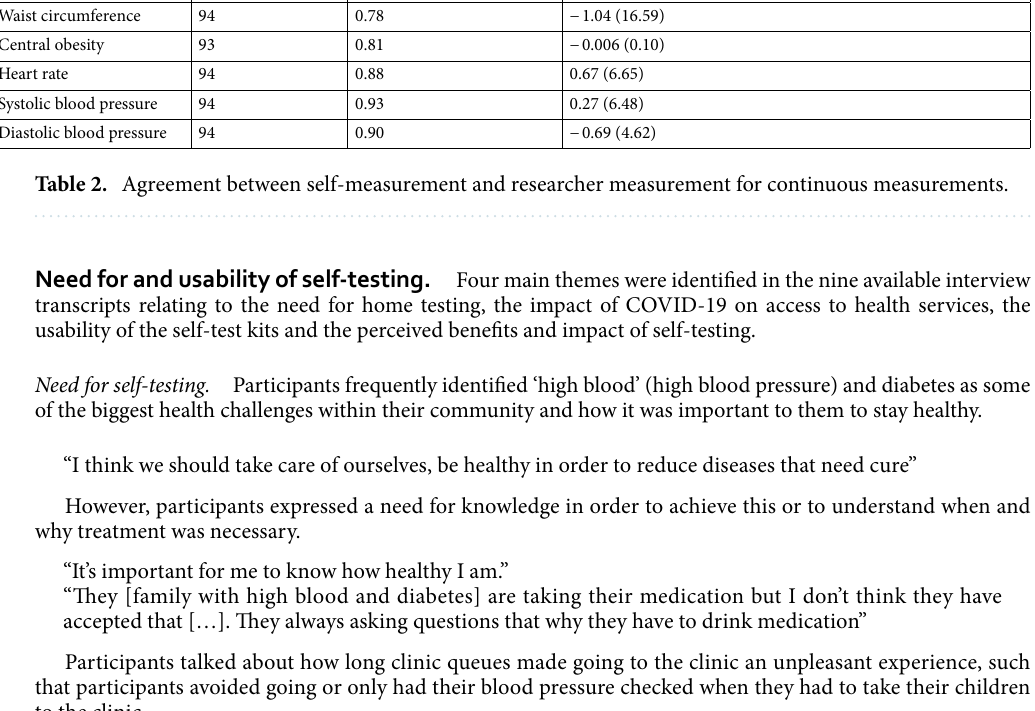
Mean of difference between self- measurement and research measurement (Standard Error)